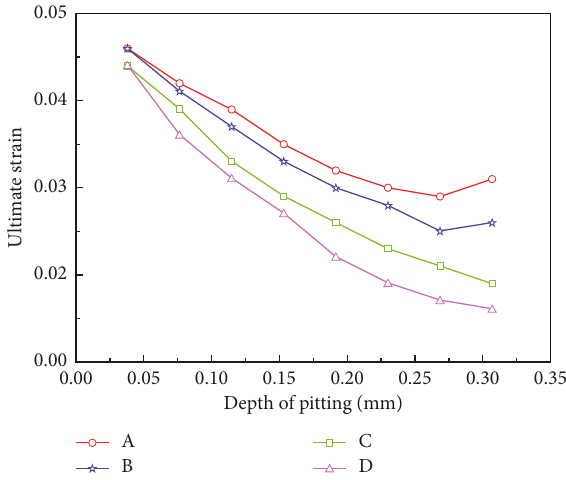
Figure 12: Influence of pitting depth on the ultimate strain of steel